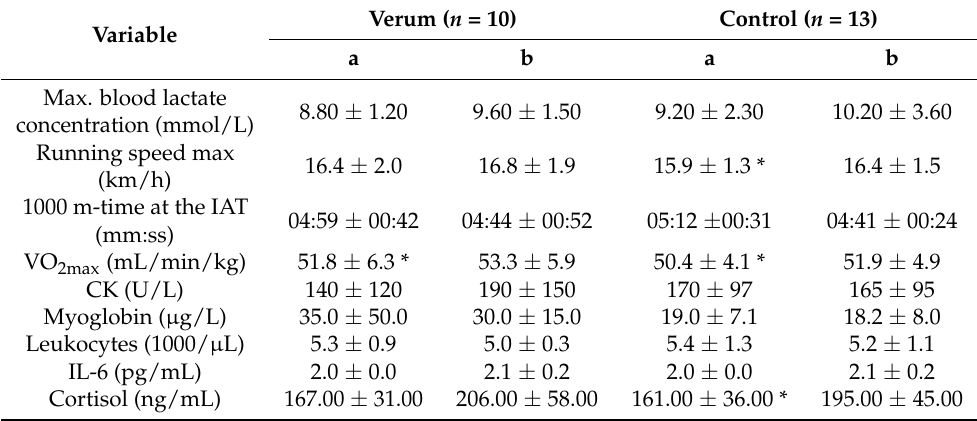
Table 2. Performance and exercise-induced stress markers measured before (time point a) and after the intervention (time point